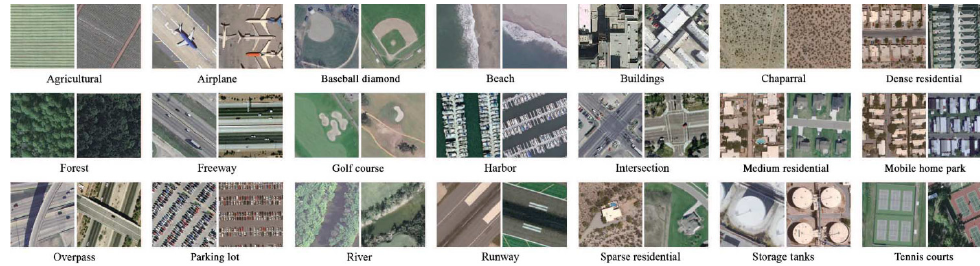
Figure 4. Two typical examples of each class of the 21-class UC Merced dataset.